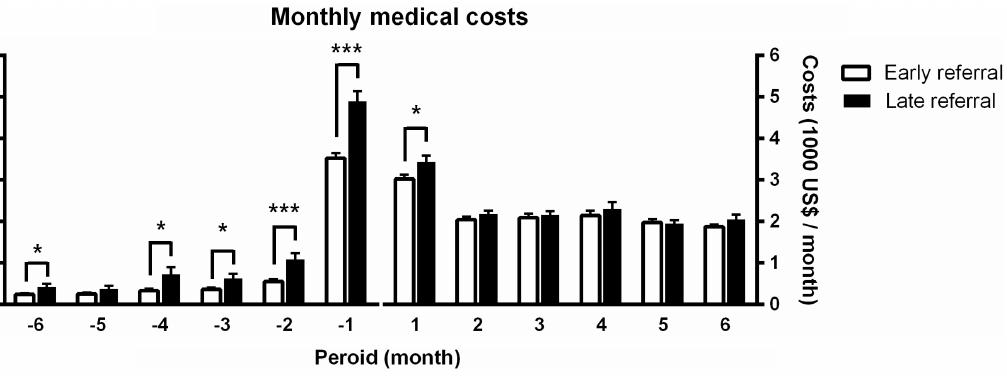
Figure 1. Monthly medical costs before and after the initiation of dialysis. The monthly medical costs are represented, comparing ‘early referral’ and ‘late referral’ according to the time period. The values (unit: US dollars) are expressed as the mean 6 SEM. * P , 0.05, *** P , 0.001.